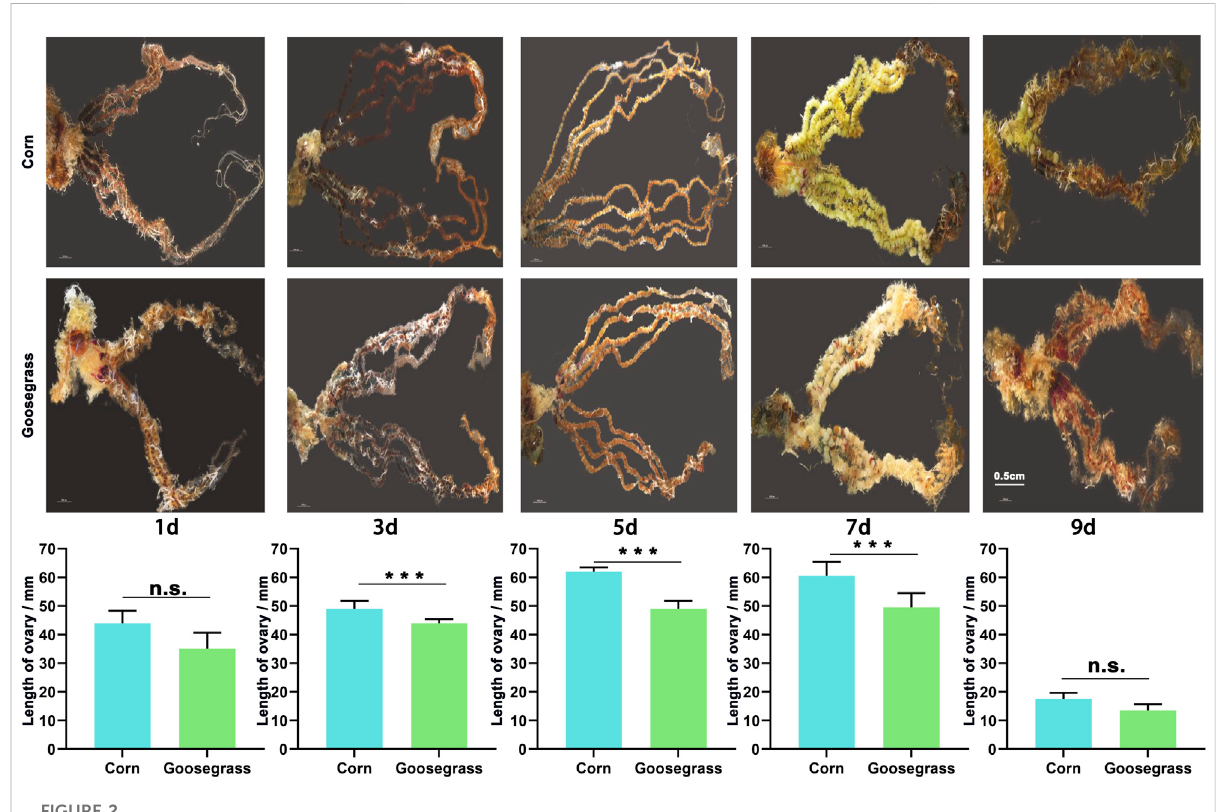
FIGURE 2 Effects of corn and goosegrass on the sizes of ovaries in S. frugiperda